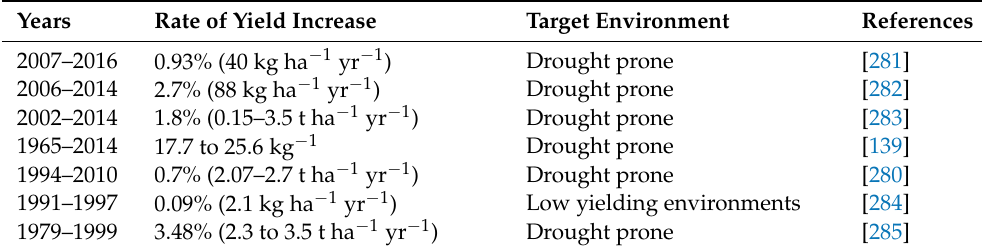
Table 7. Rates of yield gains realised from international breeding programs using CYMMIT lines under marginal